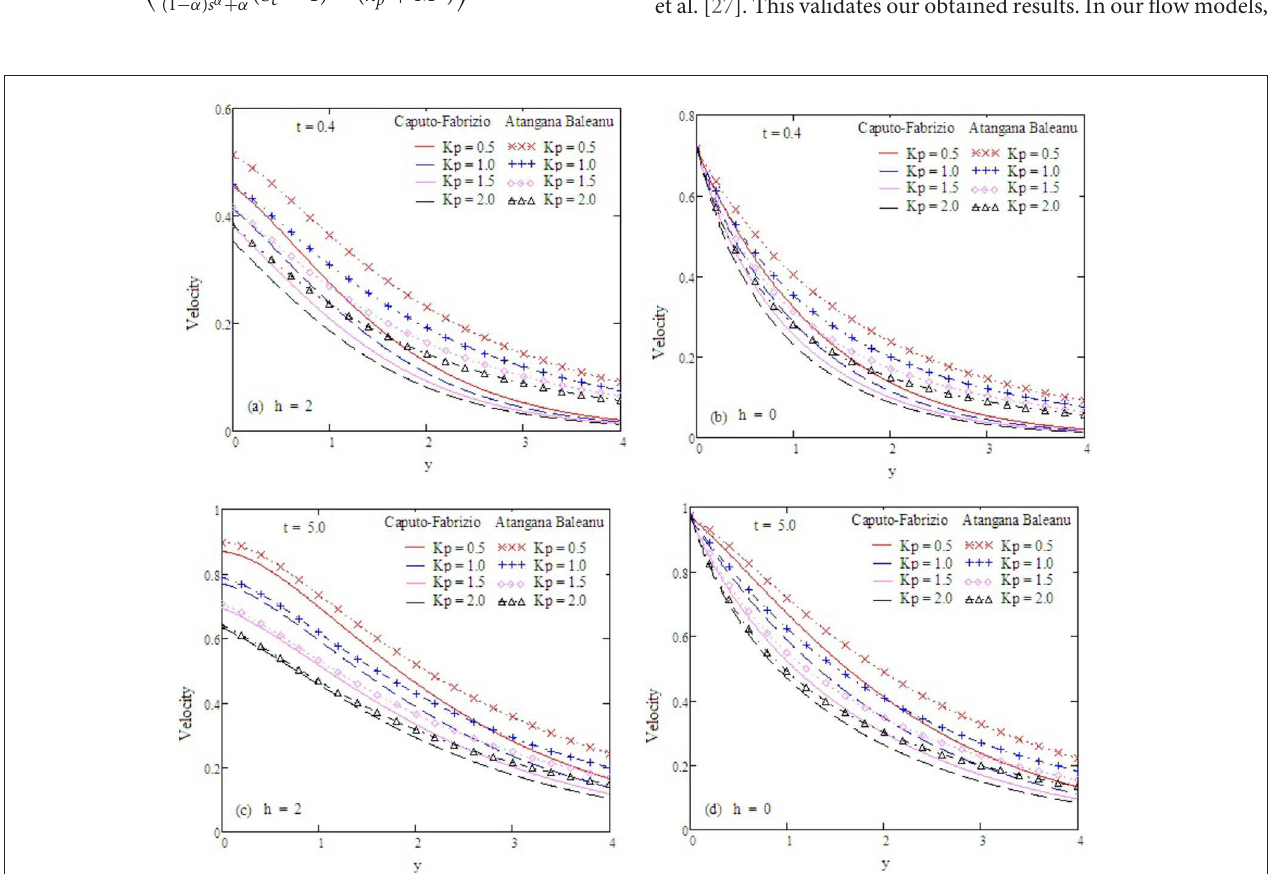
0.2, G r 2, P reff 0.1, G m 0.75, α 0.5, S c 0.5, and M = = = = = =